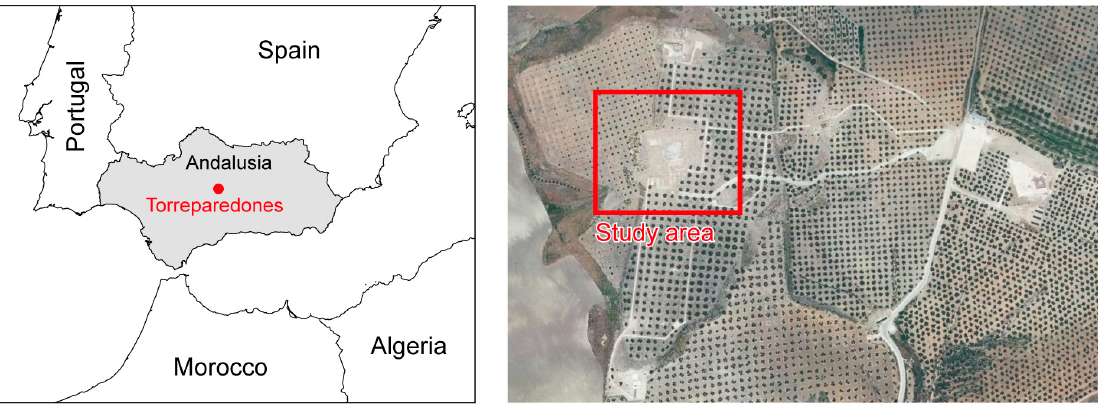
Figure 2. Overview of the study site.